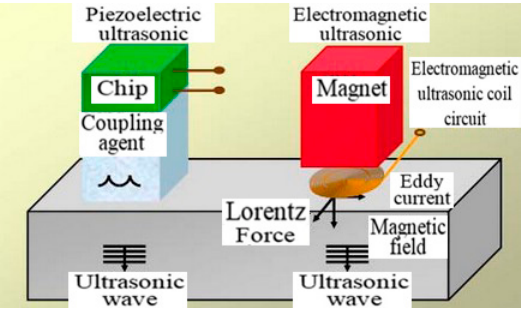
Figure 14. The comparison of electromagnetic and piezoelectric ultrasonic testing.